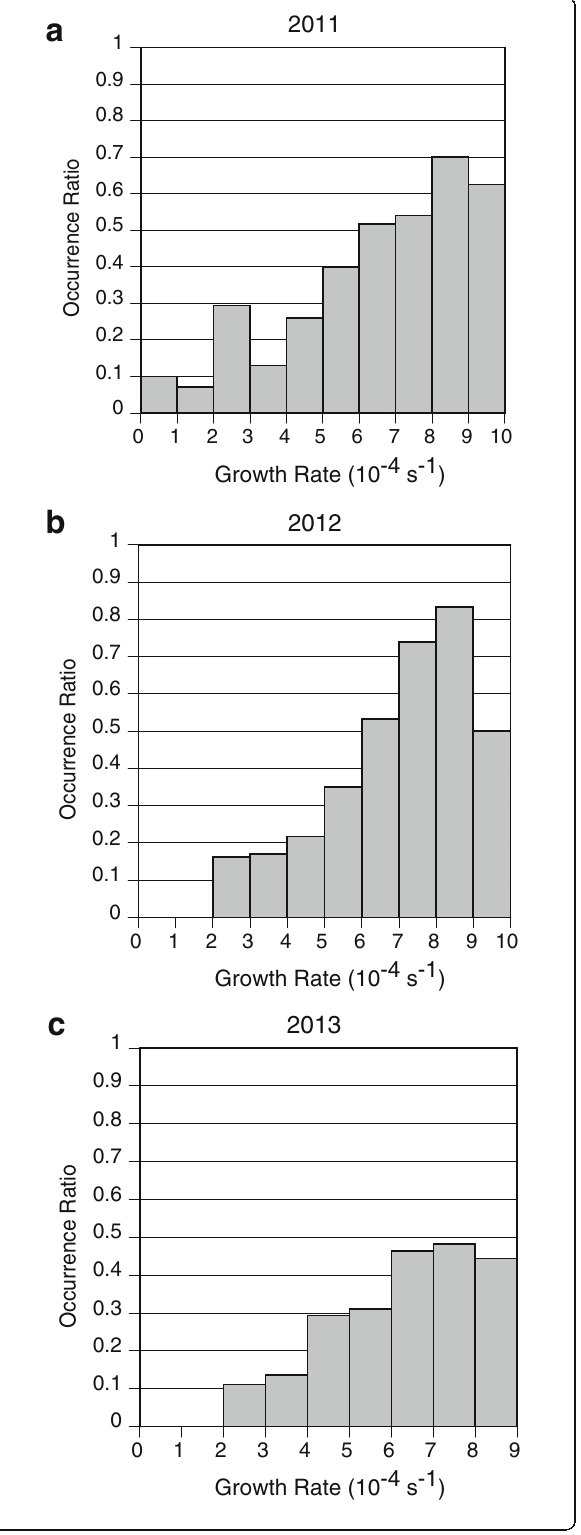
Fig. 4 Histograms of the number of EPS occurrence/non-occurrence days for the R-T growth rate. The histograms indicate the relationship between the rate of days of EPB occurrence and the R-T growth rate in a 2011, b 2012, and c